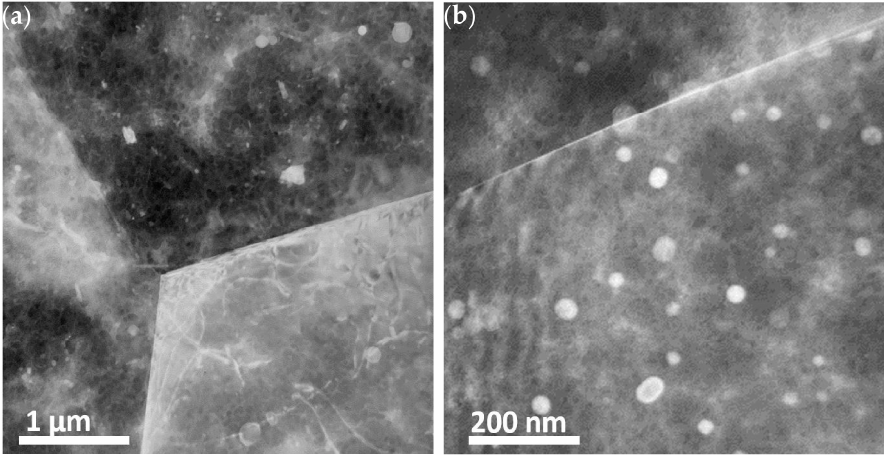
Figure 3. TEM images of alloy AZ31 ( a ) bright field (BF) overview and ( b ) higher magnification showing a random distribution of particles of various sizes ranging up to a few nanometers in diameter.